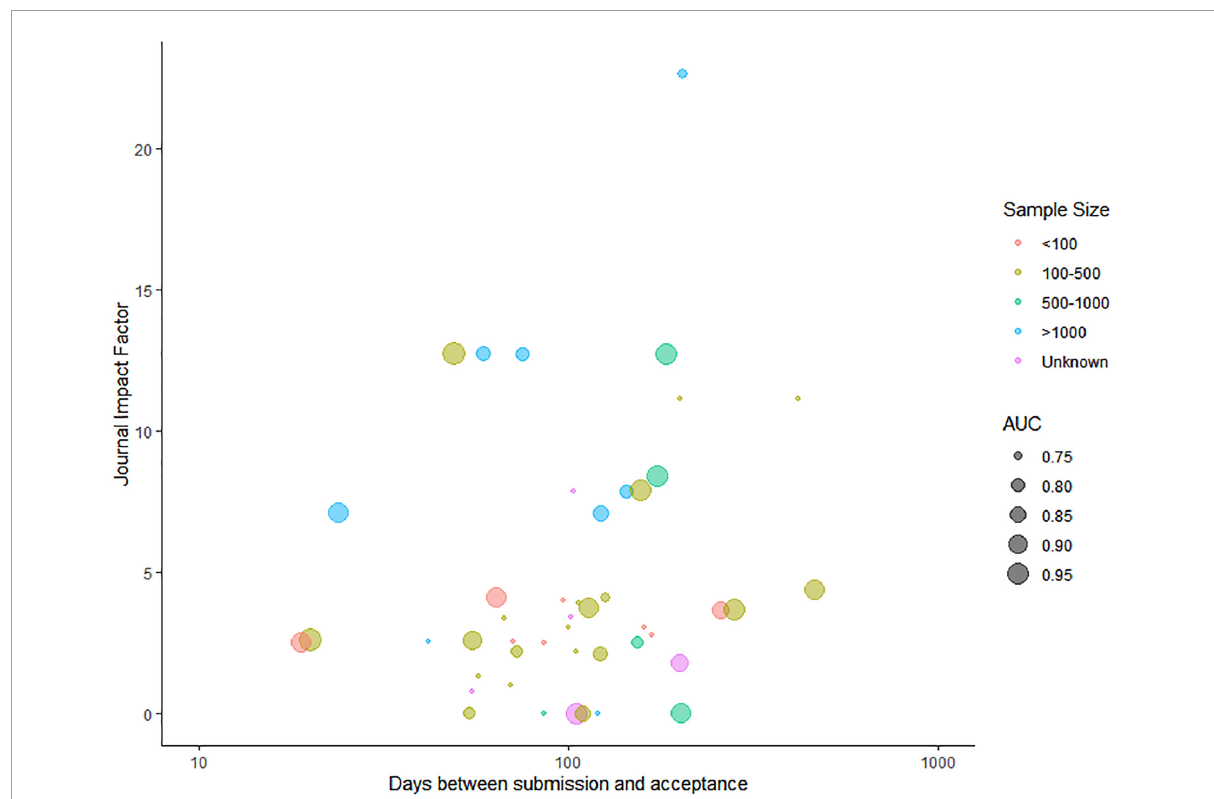
FIGURE3 Relationship between the time needed for acceptance for publication and the journal impact factor.